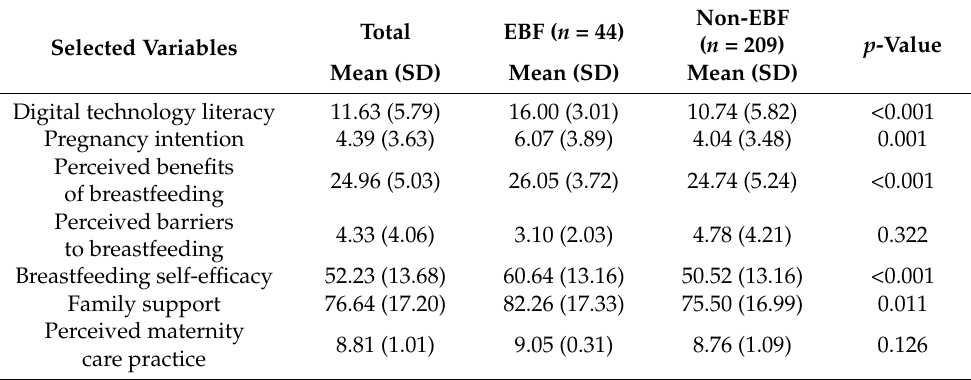
Table 3. Comparison of selected variables between exclusively breastfeeding mothers ( n = 44) and non-exclusively breastfeeding mothers ( n =